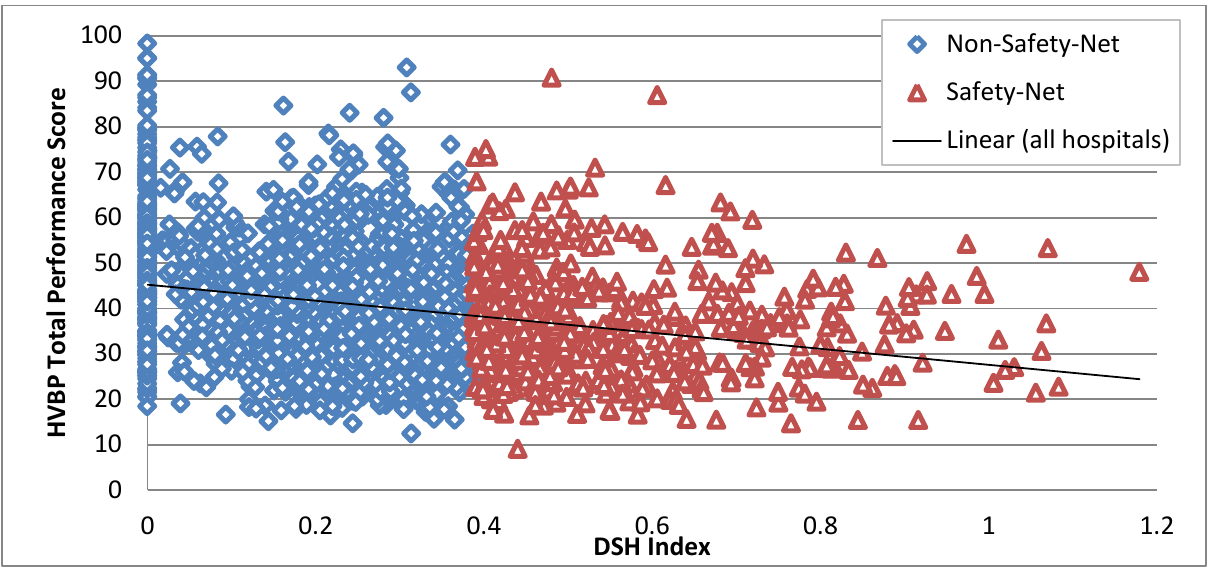
Figure 14.2: Relationship Between DSH Index and HVBP Total Performance